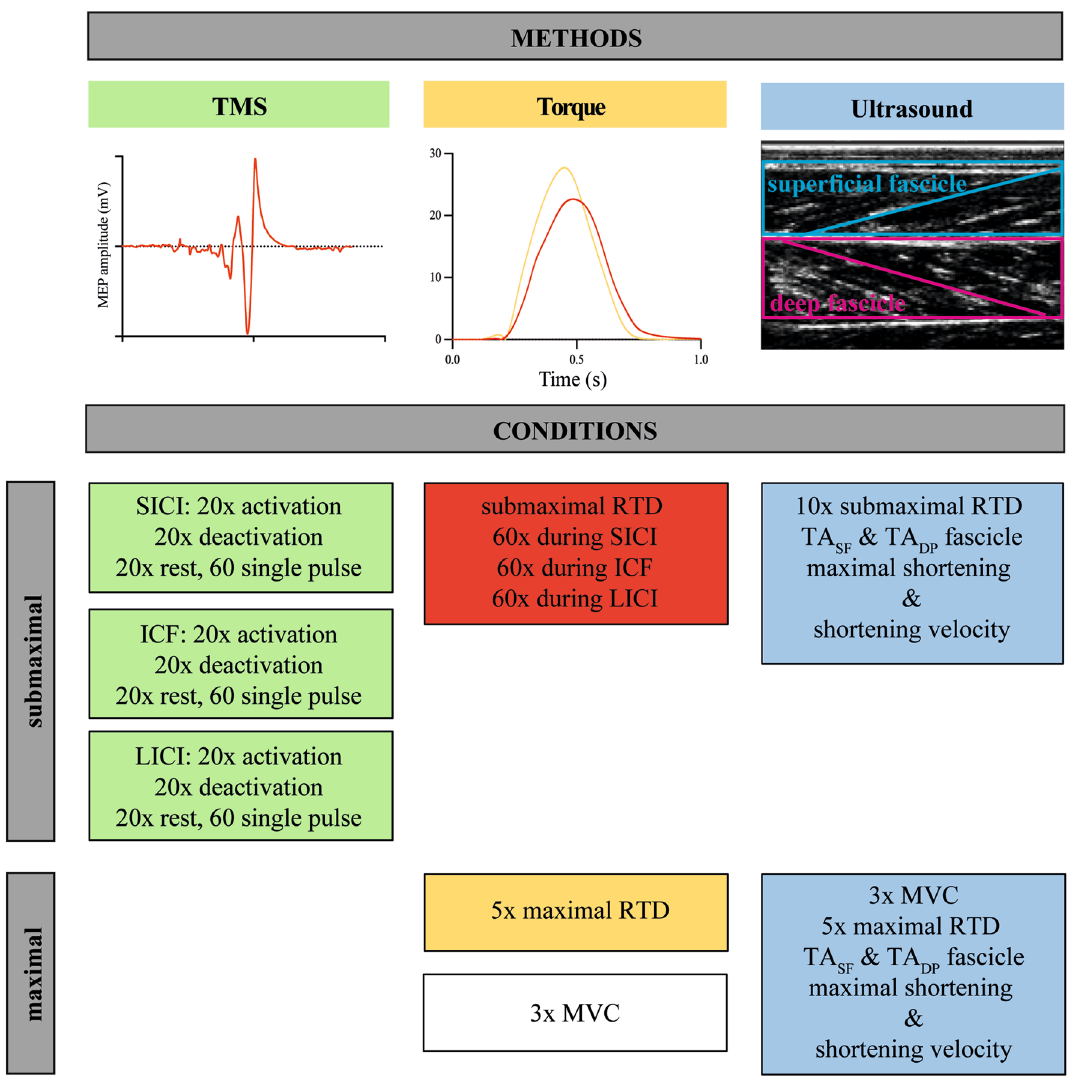
Figure 1. Overview about the methods and experimental conditions of the current study. TMS was measured during rapid submaximal fixed-end dorsiflexions, at rest, and during the activation and deactivation phase of the fixed-end contraction. Ultrasound of the TA SF and TA DP were measured during submaximal as well as maximal rapid contractions and fascicle behavior was analyzed for the activation (shortening) and deactivation (lengthening) phase. Torque was measured during all